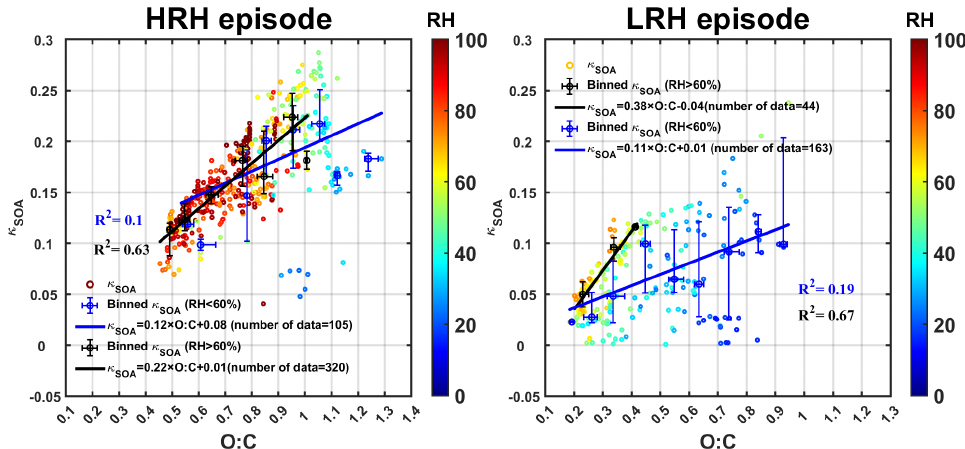
Figure 9. The plots of κ SOA vs. O : C ratios during the HRH and LRH episodes. The black line and blue line are the fitting to the measured data at RH < 60% and RH > 60%, respectively. The blue and black points show that κ SOA values were usually binned by O : C with an increment of 0.1. The color bars indicate